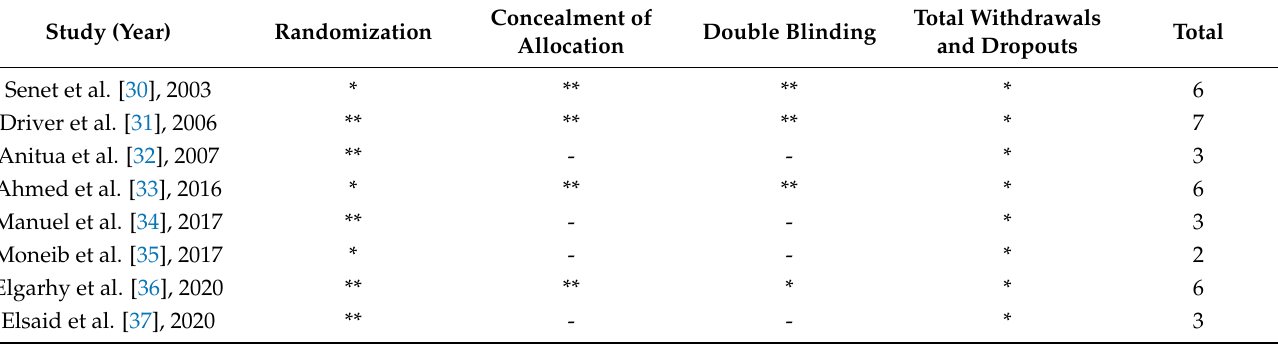
Table 3. Modified Jadad Score for the investigated studies. Each asterisk represents one point. The score is used to assess the quality of clinical trials; when the score was ≥ 4 points, the trials were considered high